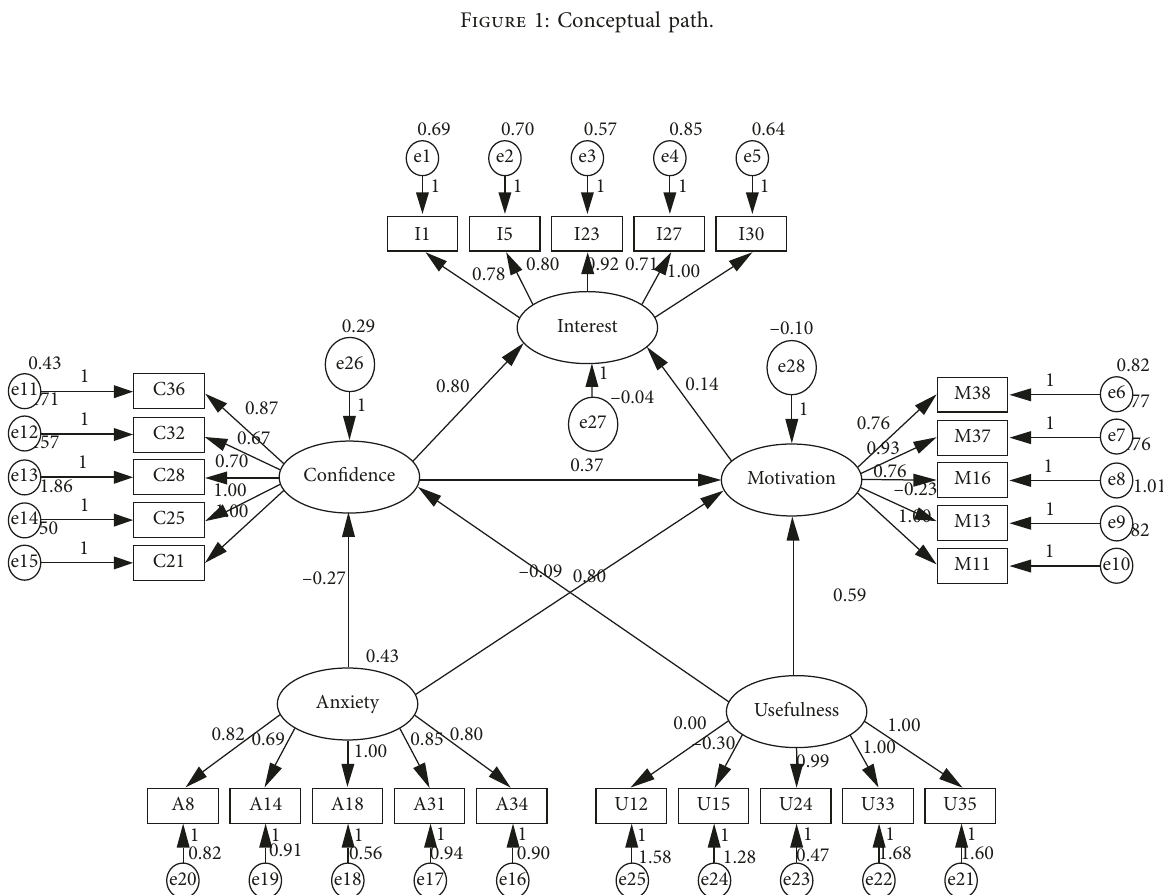
Figure 1: Conceptual path.